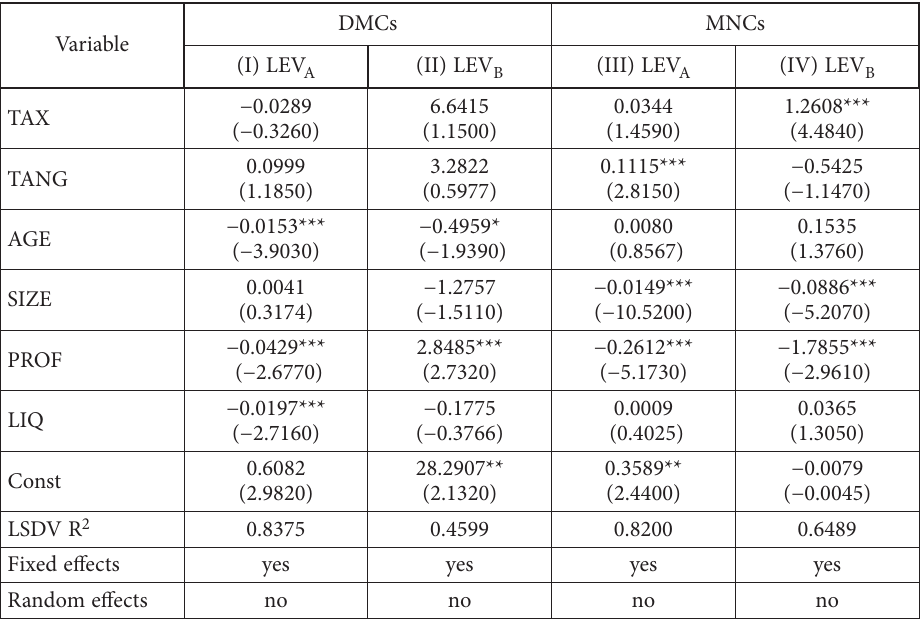
Table 7. Regression results: